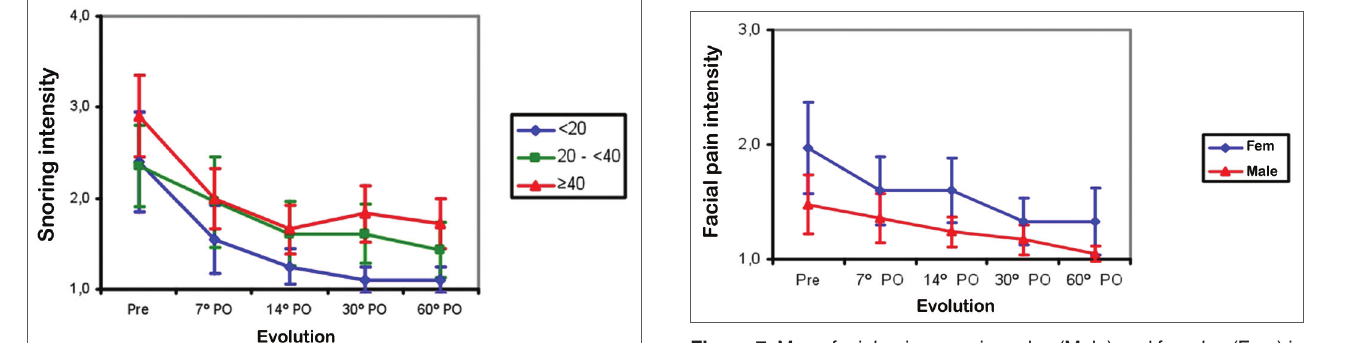
Figure 7. Mean facial pain score in males (Male) and females (Fem) in the preoperative (Pre) and postoperative (PO)